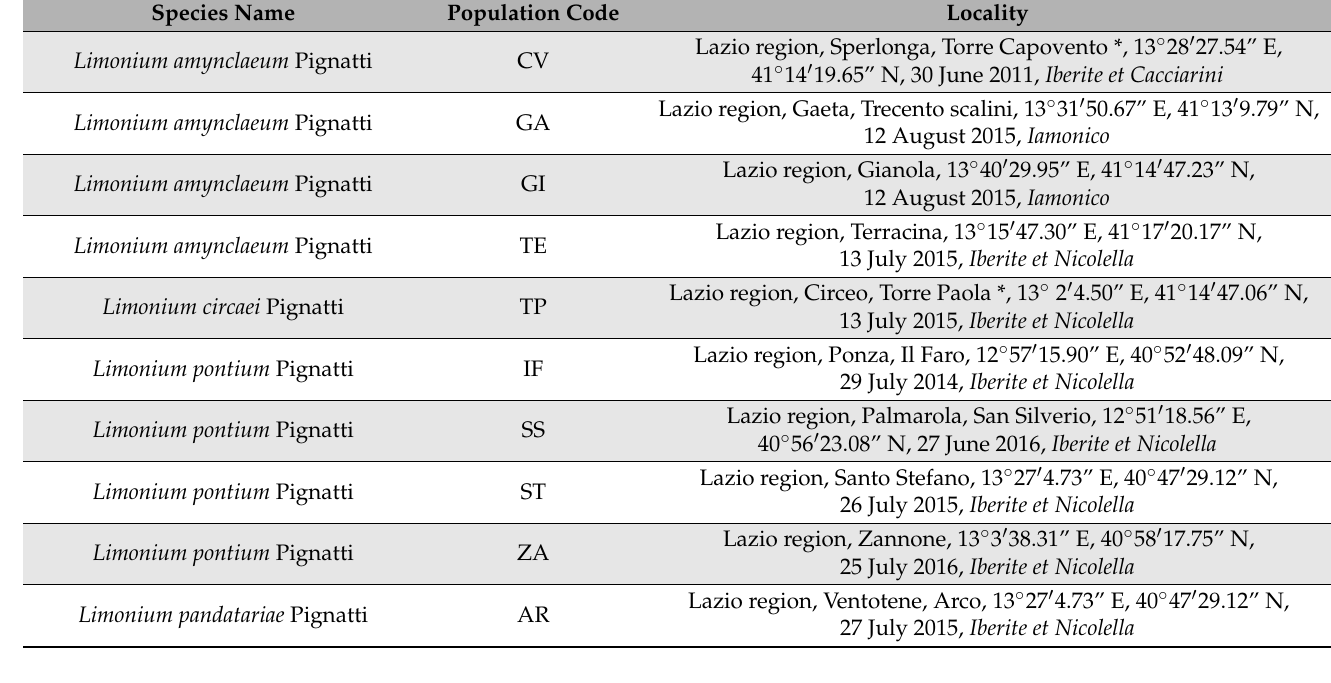
Table 1. Populations studied. Asterisk (*) indicates the locus classicus. Species names according to Brullo and Guarino [27].